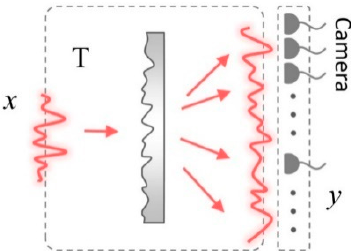
Figure 2. Schematic representation of the SSM method. An optical field incident x is scattered by an optical diffuser. The scattered field y is imaged by a camera. The scattered and the incident fields are related by the transmission matrix T of the optical system. Adapted with permission from [67], APS.